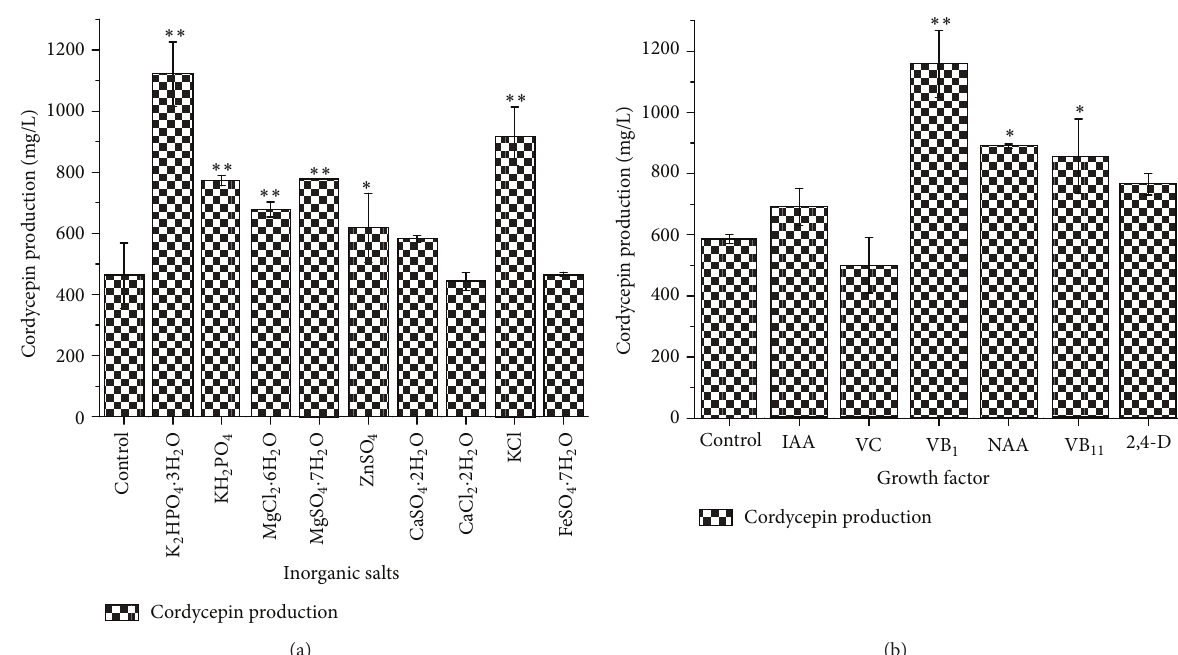
Figure 3: Effects of inorganic salt and growth factors on the production of cordycepin: inorganic salt (a); growth factors (b); ∗ 5 % significance level (test group versus control group); ∗∗ 1 % significance level (test group versus control